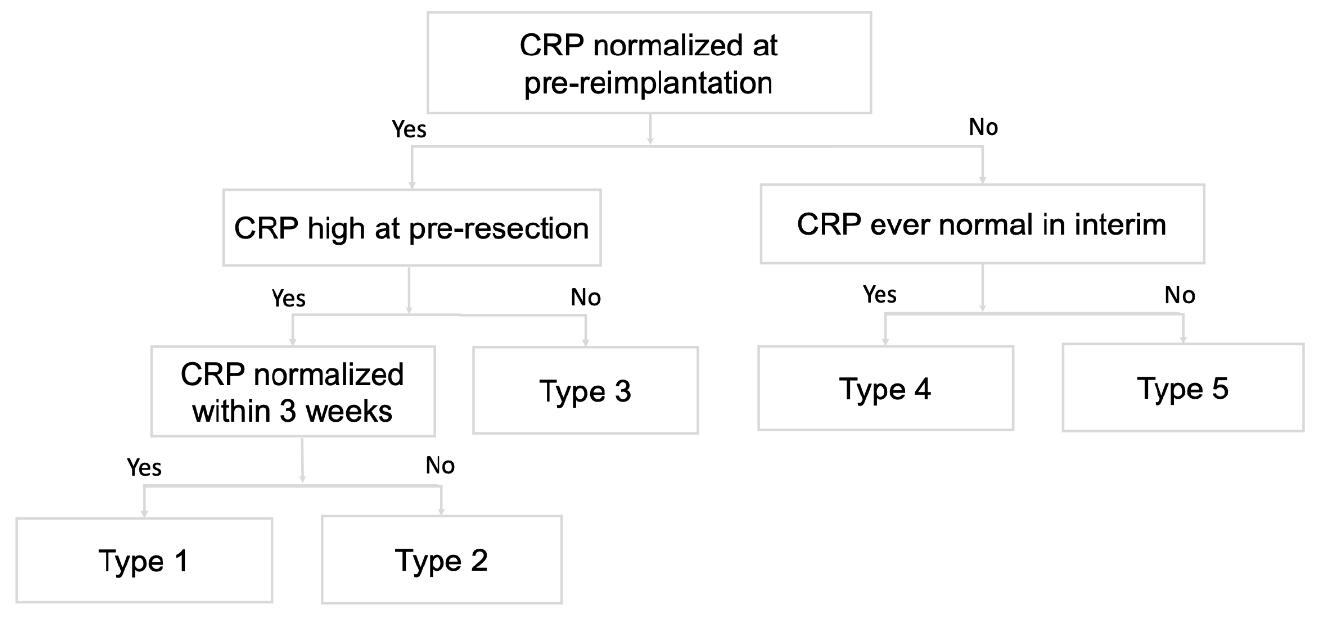
Figure 2. Qualitative CRP trends. The CRP trends during the interim period are categorized into 5 types according to the CRP levels at pre-reimplantation, pre-resection, and whether CRP is normal- ized within 3 weeks after resection.